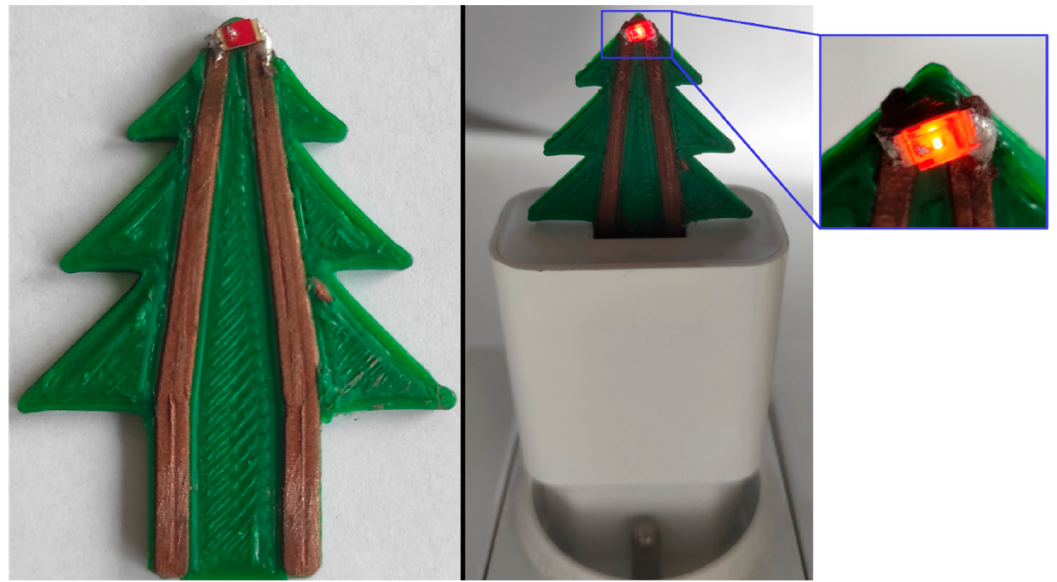
Figure 9. 3D-printed demonstrator with soldered LED on PS/Cu conductive substrate using a hot iron and SnPb soldering alloy.